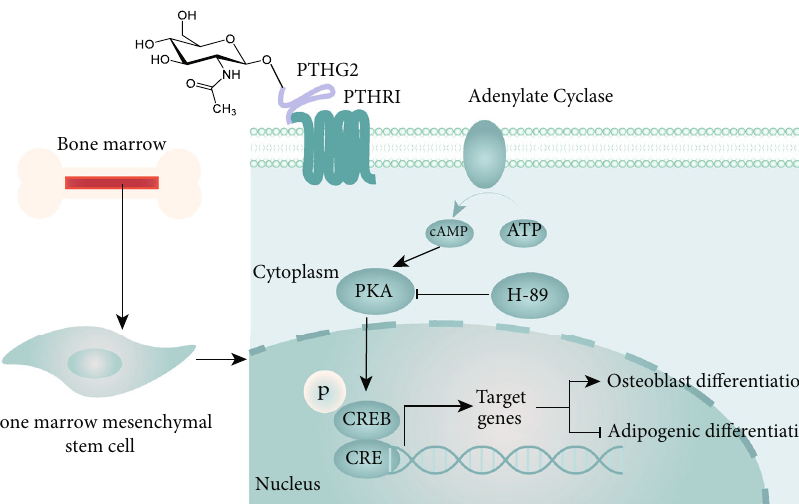
Figure 6: PTHG2 interacts with PTH (1-34) R1 to activate adenylate cyclase (AC), activate second messenger cAMP-dependent protein kinase (PKA), phosphorylation CREB into nucleus, and control downstream target genes expression, such as osteogenic genes (OCN/RUNX2/Osterix) and adipocyte production markers (Fabp4/PPAR ɣ